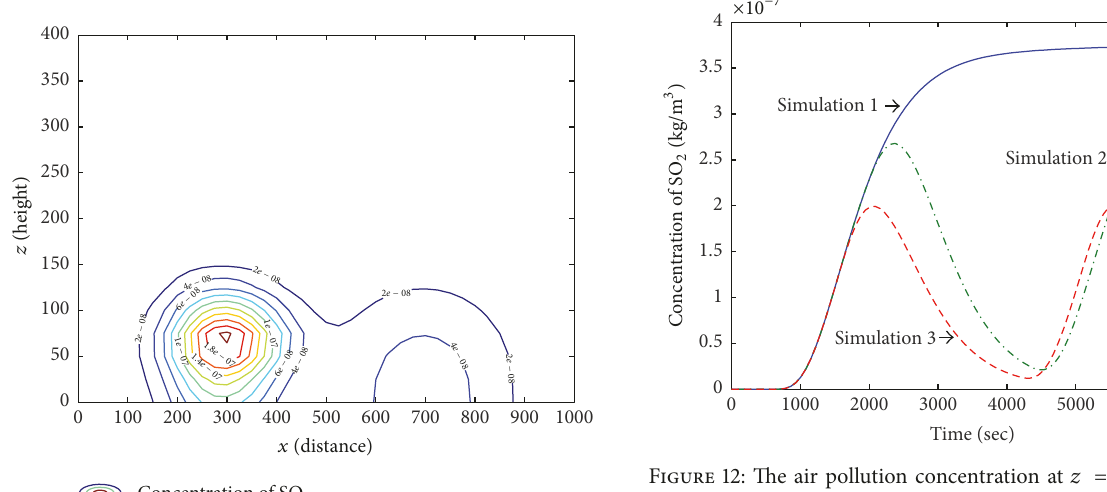
Figure 9: The air pollution concentration levels after 58 minutes have passed which are controlled by air quality standard ( 1.5 × 10 −7 kg/m 3 ).